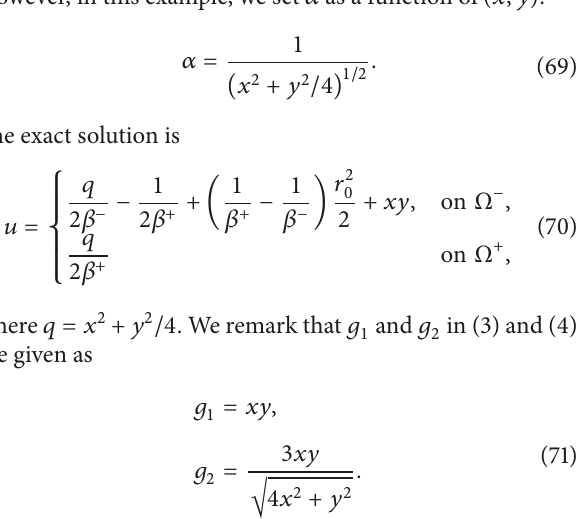
outside of Γ , respectively. The coefficients are (𝛽 − , 𝛽 + ) = = 0.4 . In the previous example, 𝛼 was (1, 10) and 𝑟 0